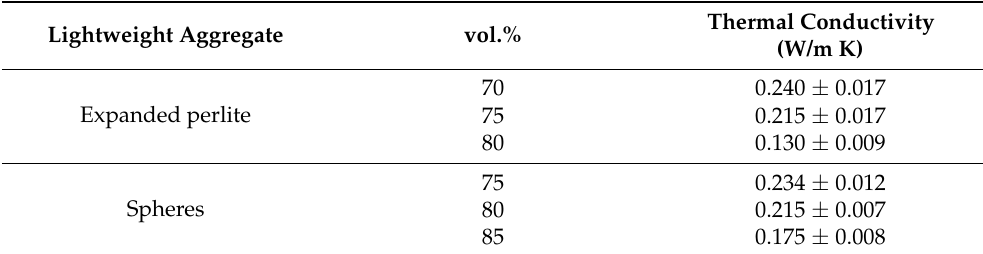
Table 2. Thermal conductivity (W/m K) of geopolymer composites produced with distinct expanded perlite and geopolymer spheres